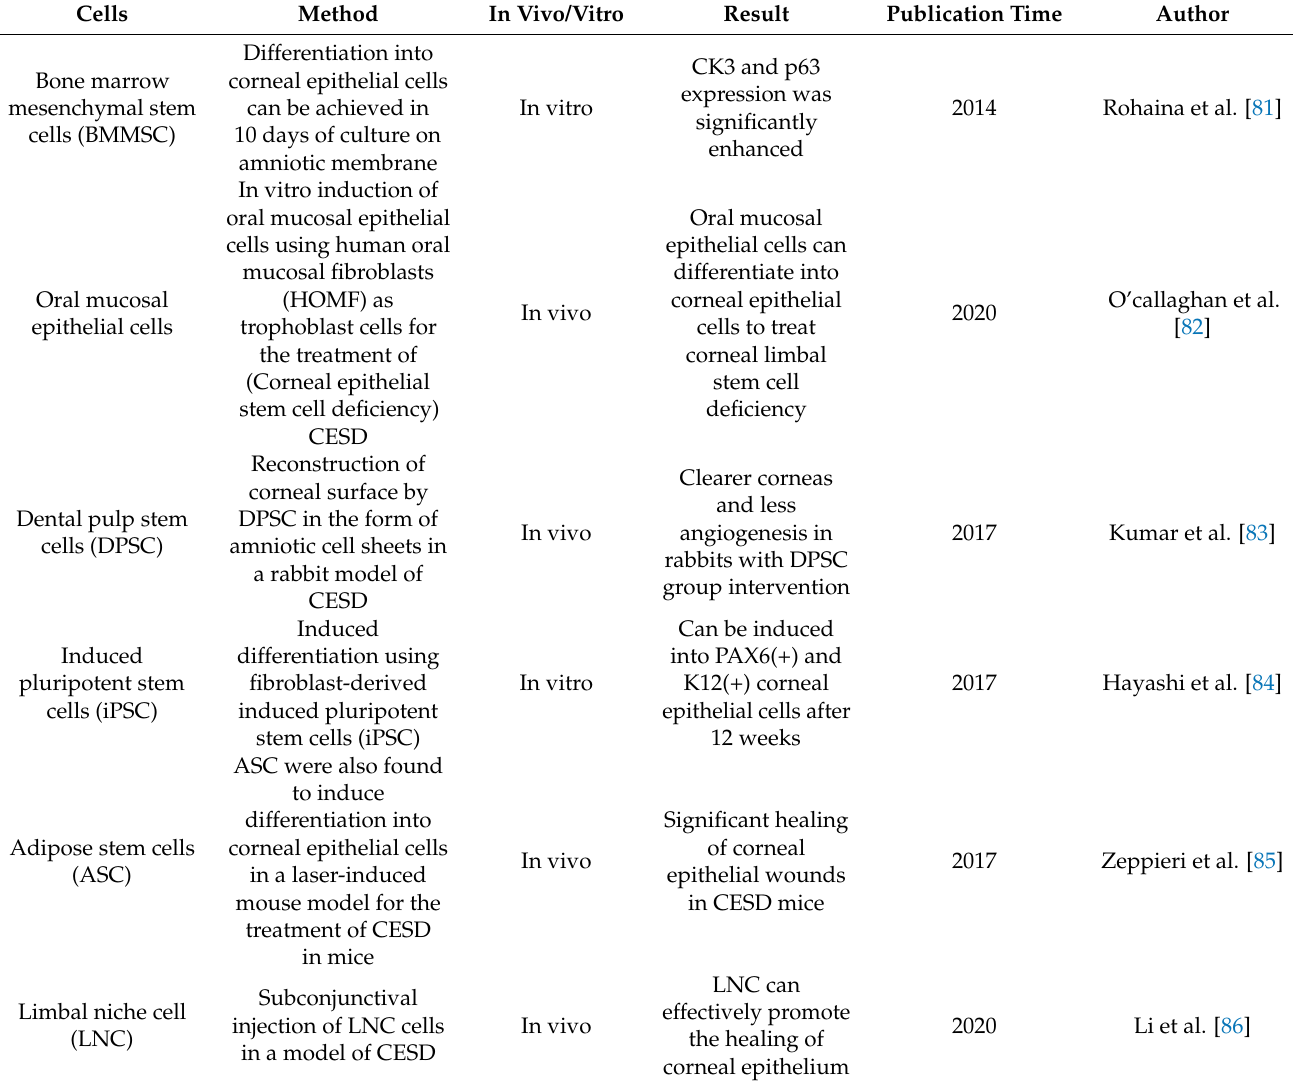
Table 2. Cell therapy application in the cornea.